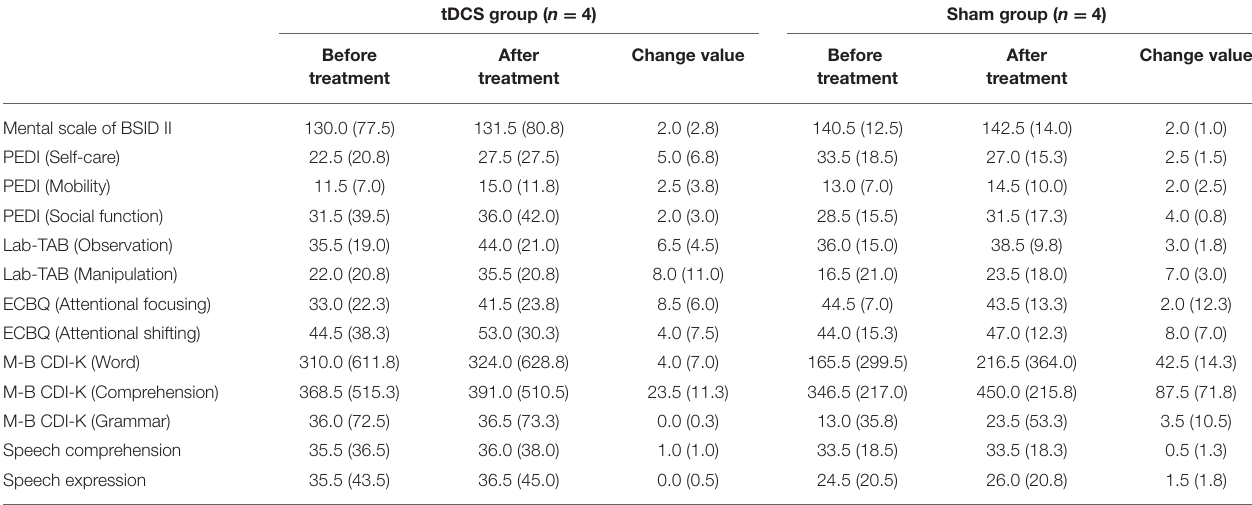
TABLE 5 | Subgroup analysis between the groups after